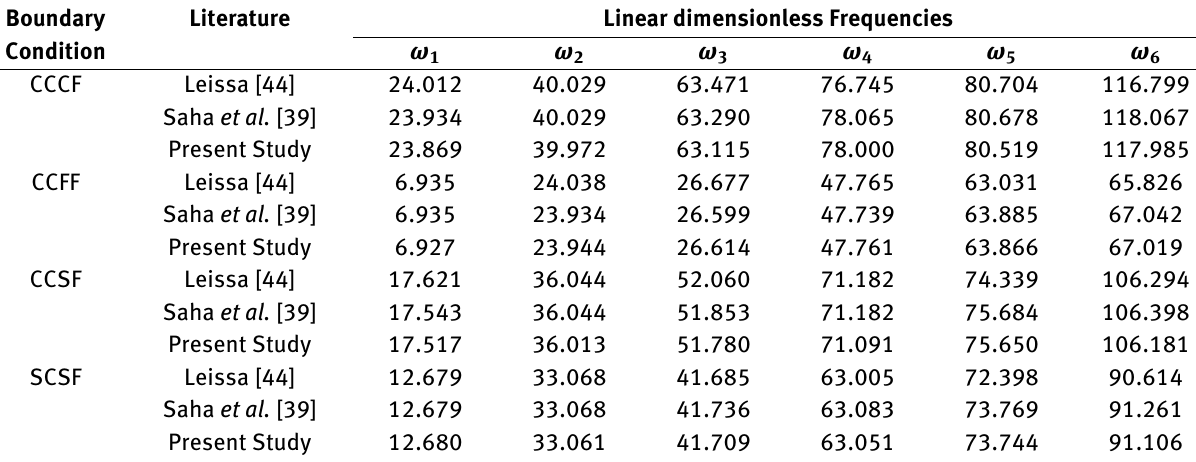
Table 2: Comparison of Linear dimensionless Frequencies Boundary